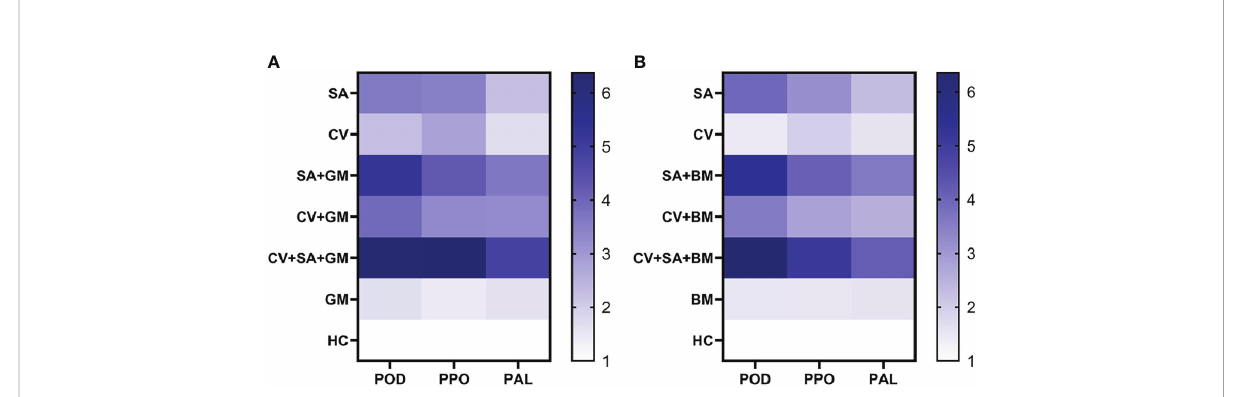
FIGURE 2 Heat map for the relative expression of PPO, POD, and PAL in sweet oranges. (A) Relative expression of PPO, POD, and PAL against green mold, (B) Relative expression of PPO, POD, and PAL against blue mold. PPO= Polyphenol oxidase, POD, Peroxidase; PAL,Phenyl alanine ammonia-